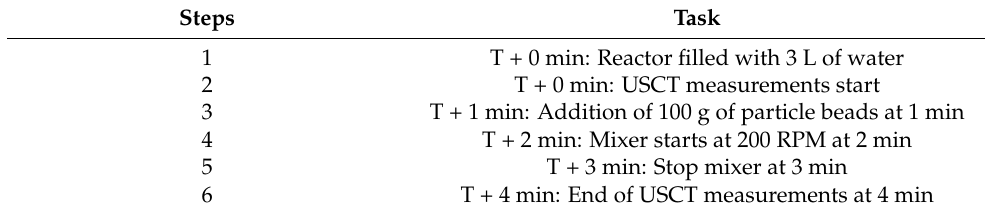
Table 2. Particle beads detection experimental